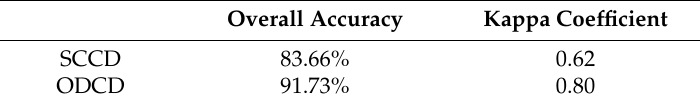
Table 12. Accuracy comparison table between SCCD and ODCD.